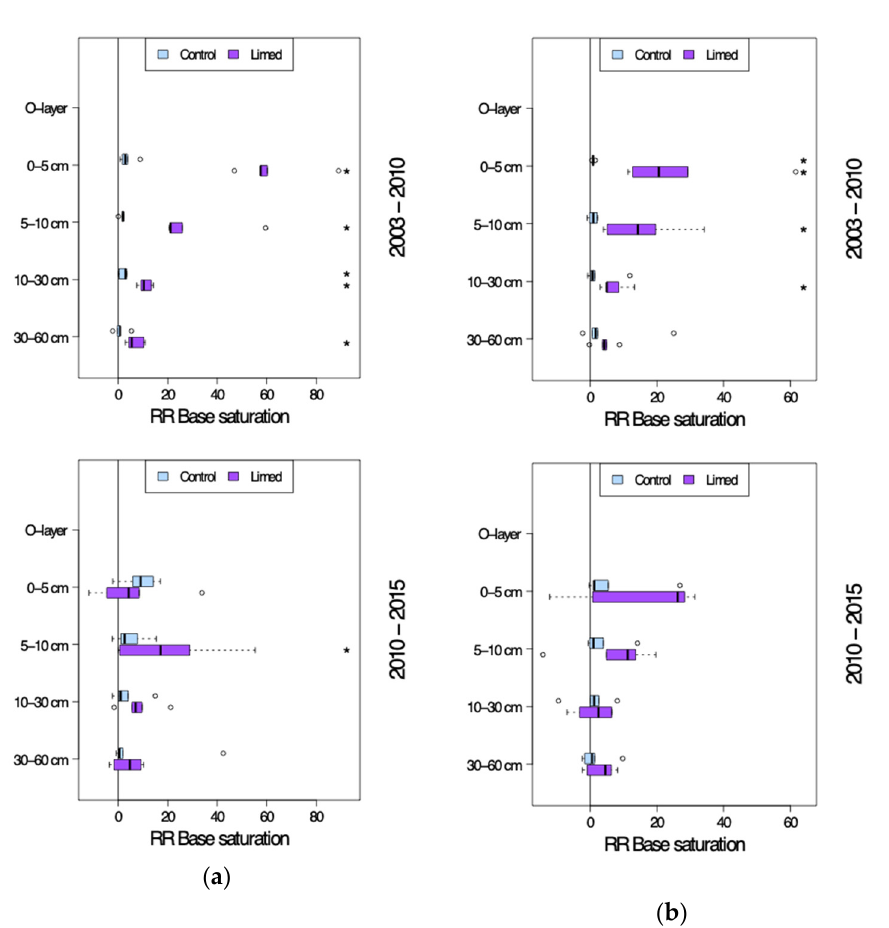
Figure 5. Base saturation site average response ratio (RR a ) seven years after (2003–2010) and twelve years after the second lime treatment (2010–2015). ( a ) G1 study sites. ( b ) G2 study sites. *—significant differences between current and previous sampling campaign.